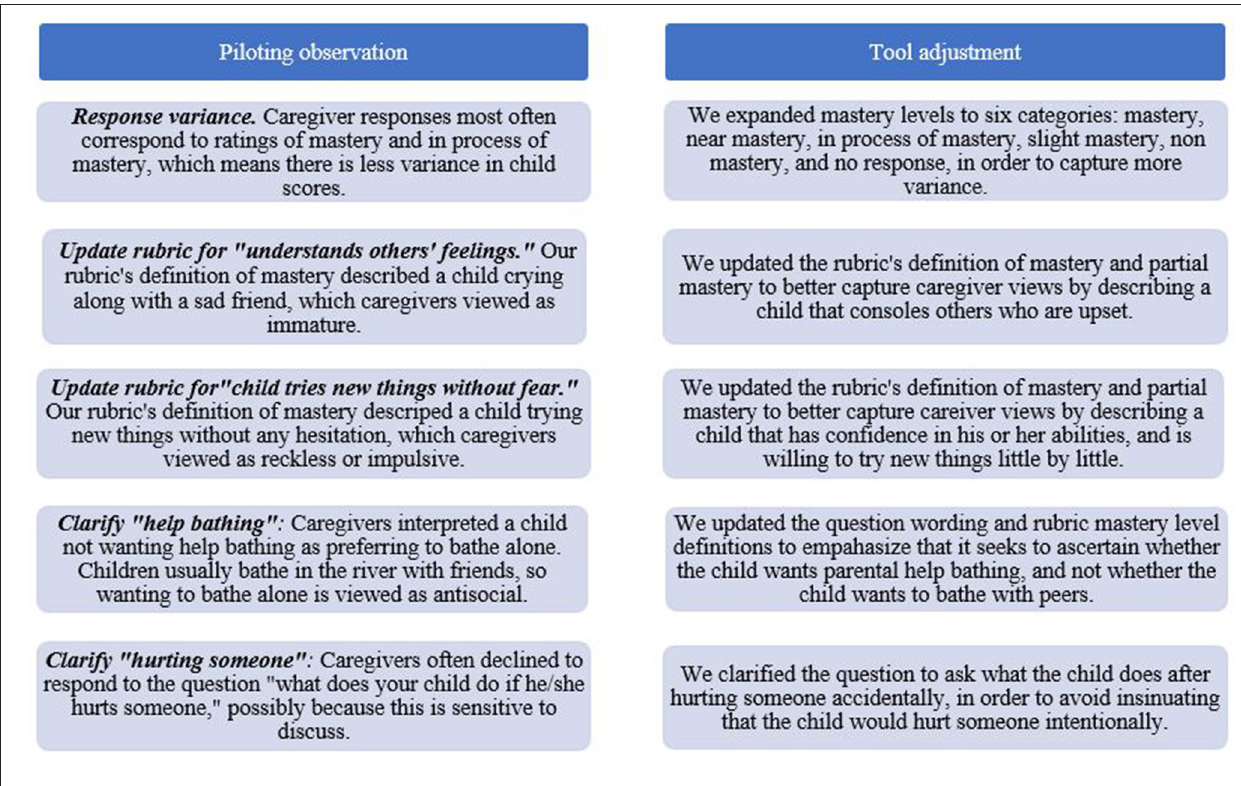
FIGURE 4 | Updates to caregiver tool post-piloting.